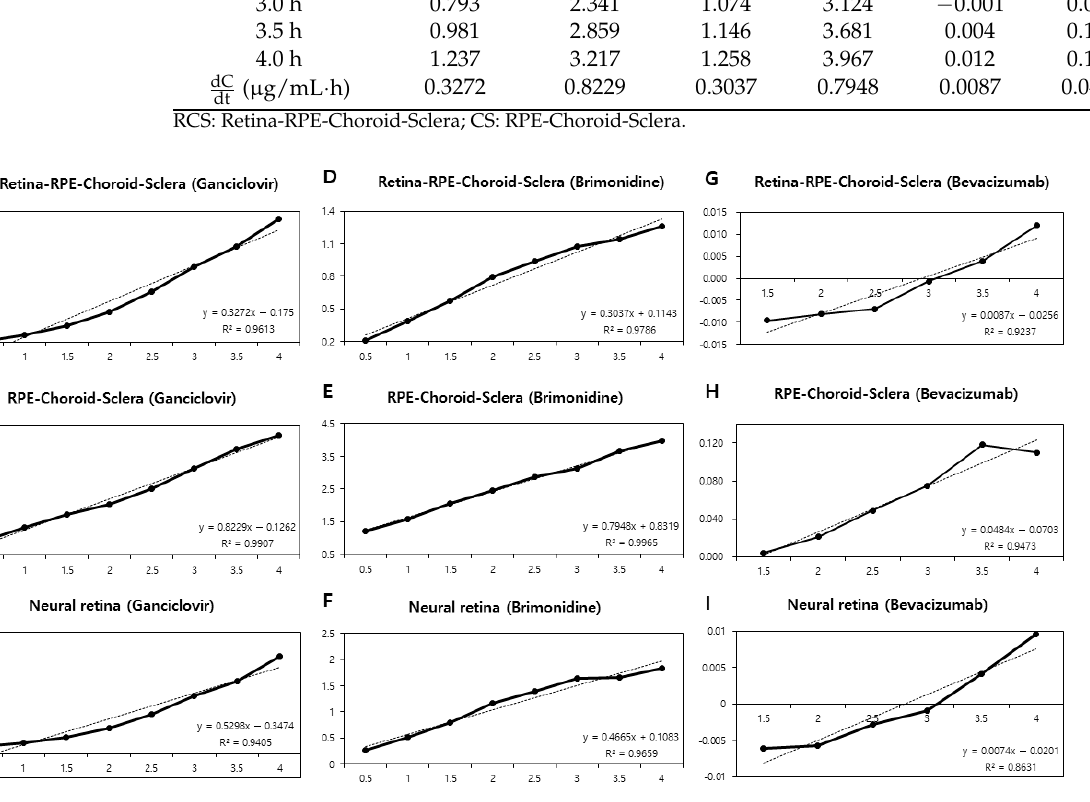
indi- indicates (cid:2914)(cid:2930) dt